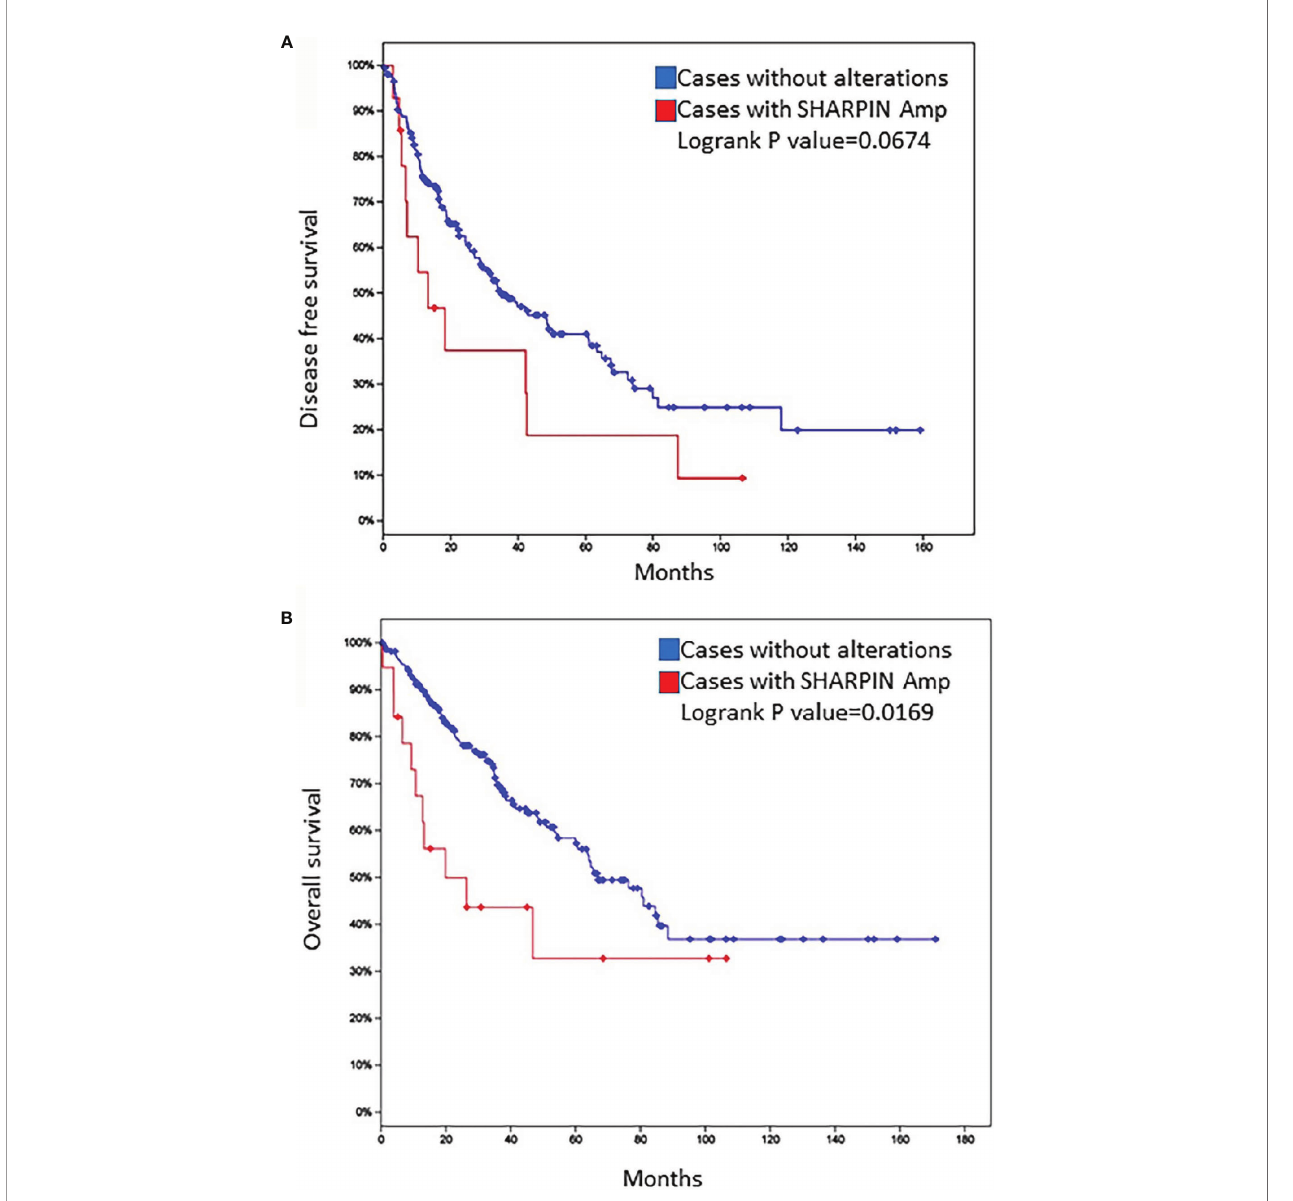
FIGURE 2 | Disease-free survival (A) and overall survival (B) of patients with sarcoma in the TCGA database according to the status of SHARPIN gene ampli fi